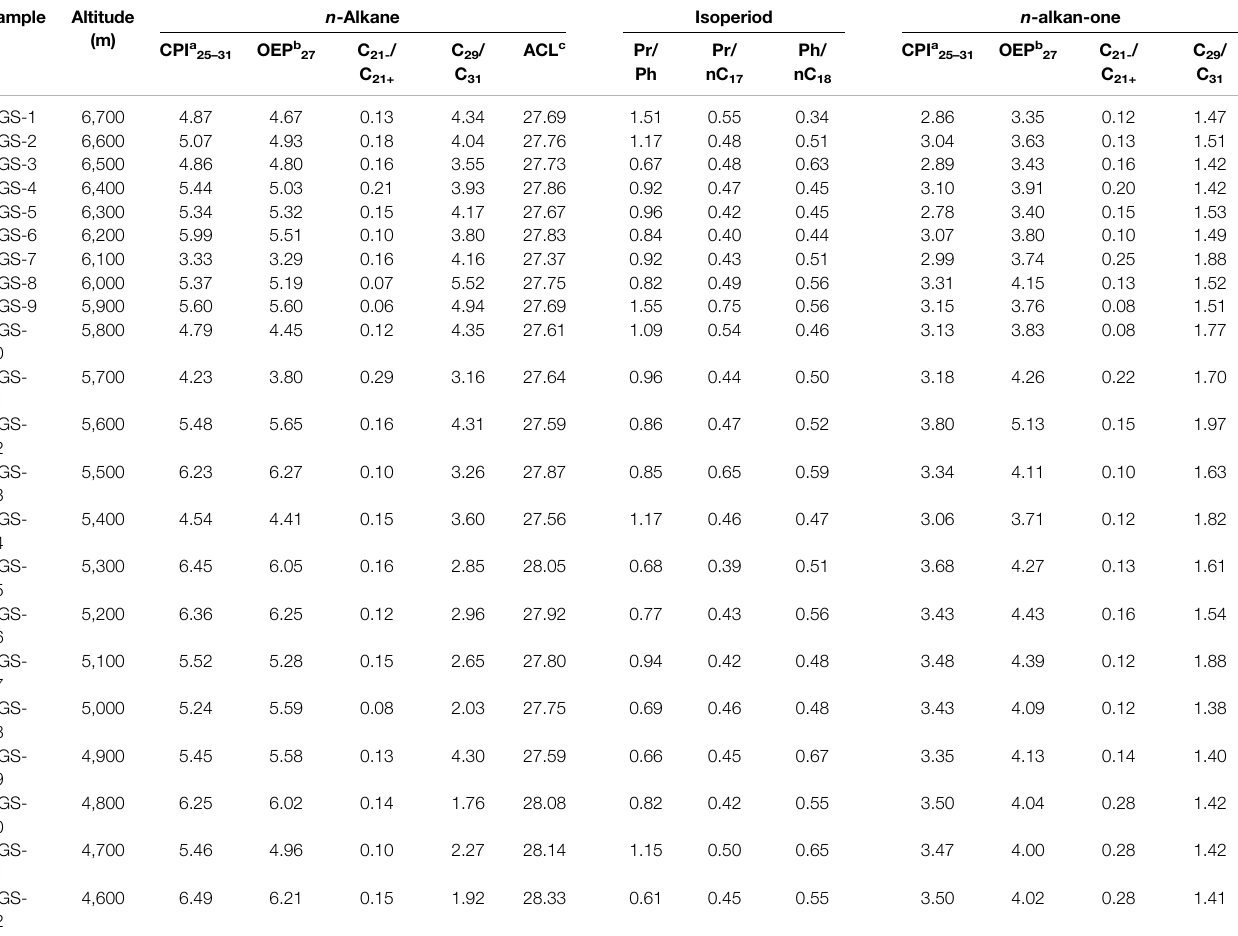
TABLE 2 | Altitude and biomarker parameters of the sediment samples along eastern slope of Gongga Mountain. Sample Altitude